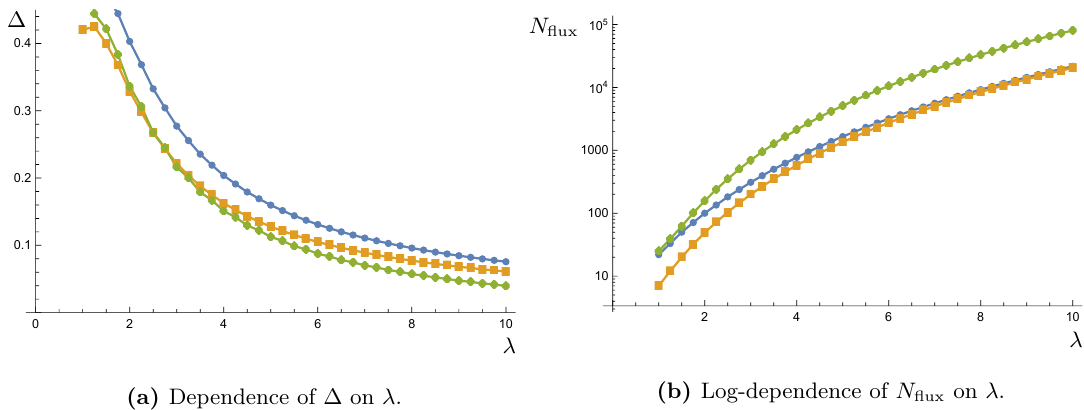
(b) Log-dependence of N flux on λ . Figure 3. Large complex-structure limit for h 2 , 1 = 2 : dependence of the relative difference ∆ and of the tadpole contribution N on the hierarchy parameter λ . The plots show three different flux families, which all show a similar